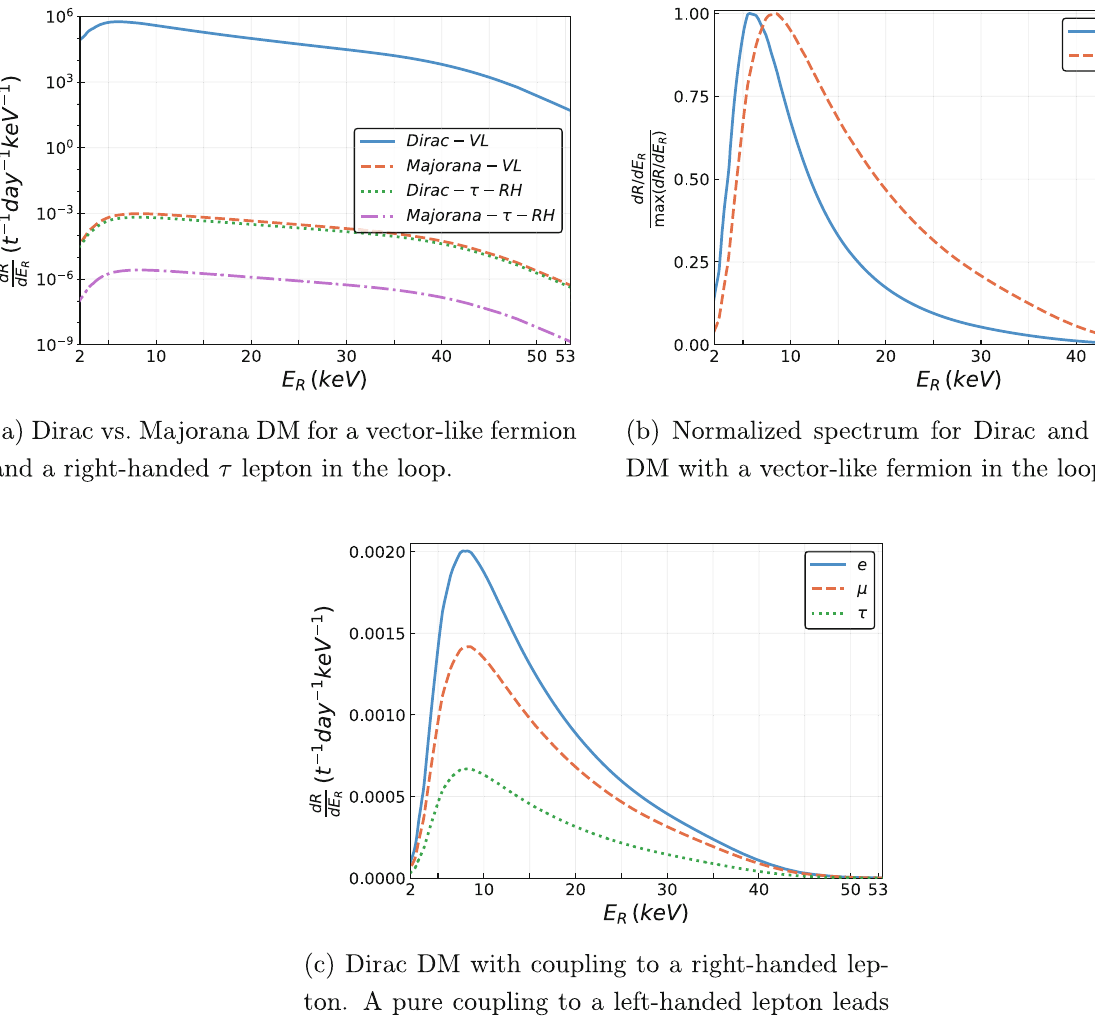
Fig. 4 DifferentialeventratesfordifferentcombinationsofDMcandi- dates and fermions in the loop. The DM mass is m ψ = 90 GeV and the Higgs portal coupling is λ HS = 3. In the case of a vector-like fermion